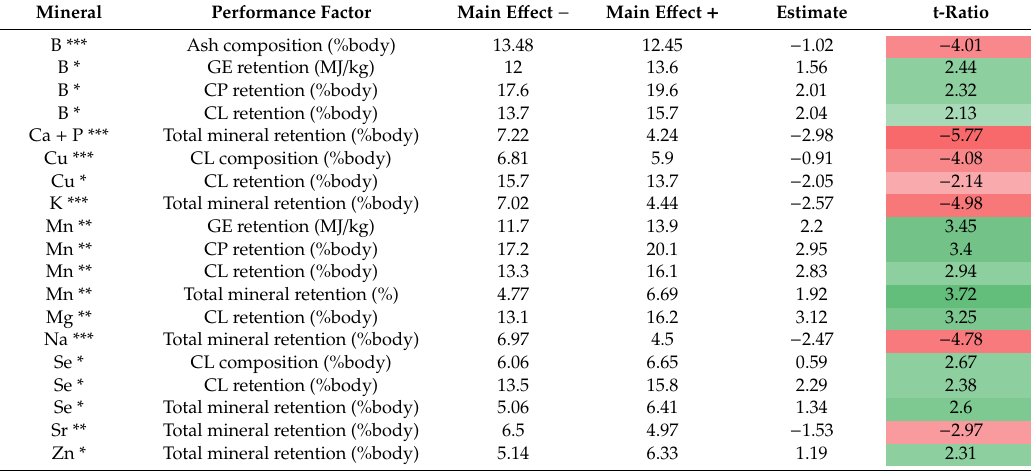
Table 6. E ff ect of significant mineral inclusions on prawn body content (%) and retention (%) sampled at Day 42 including ash composition 1 , CL composition 2 , GE retention 3 , CP retention 4 , CL retention 5 , and total mineral retention 6 using two-level screening analysis. p -values are denoted by an asterisk (* p < 0.05, ** p < 0.01, *** p < 0.001). t-ratios of minerals highlighted green have a positive e ff ect and red have a negative e ff ect on the performance parameter where the shading reflects the magnitude (i.e., darker shading has a higher magnitude of e ff ect and vice